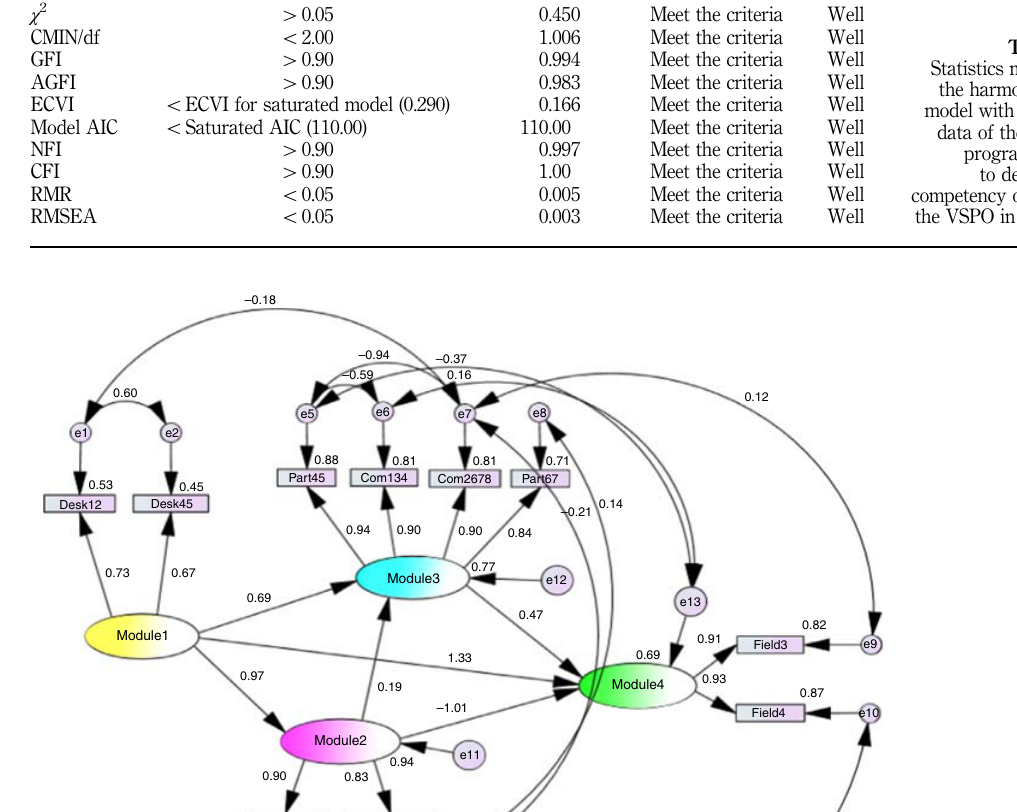
Figure 2. The second-order CFA model of the training program